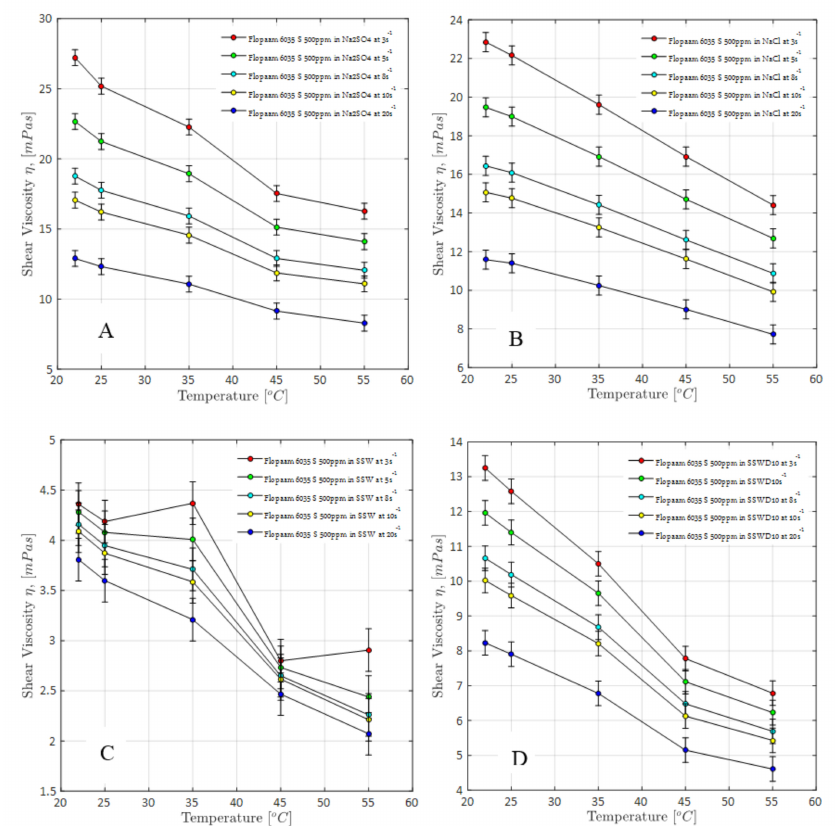
Figure 3. Steady-shear viscosity of polymer solutions at a temperature range of 22–55 ◦ C and shear rates of 3, 5, 7, 10 and 20 s − 1 . Diluted solutions were prepared in four di ff erent brines, described in Table 1. ( A ) Represents diluted solution prepared in Na 2 SO 4 brine, ( B ) shows solution prepared in NaCl brine, ( C ) depicts results of solutions prepared in SSW, while ( D ) represents solutions prepared in diluted